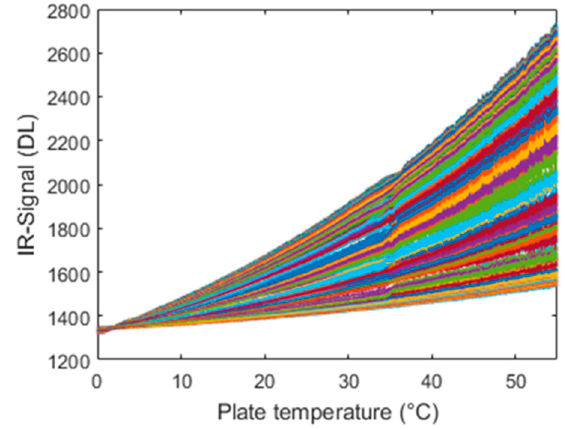
Figure 2. Example of recorded Digital-Level (DL) signal for each pixel of a droplet.